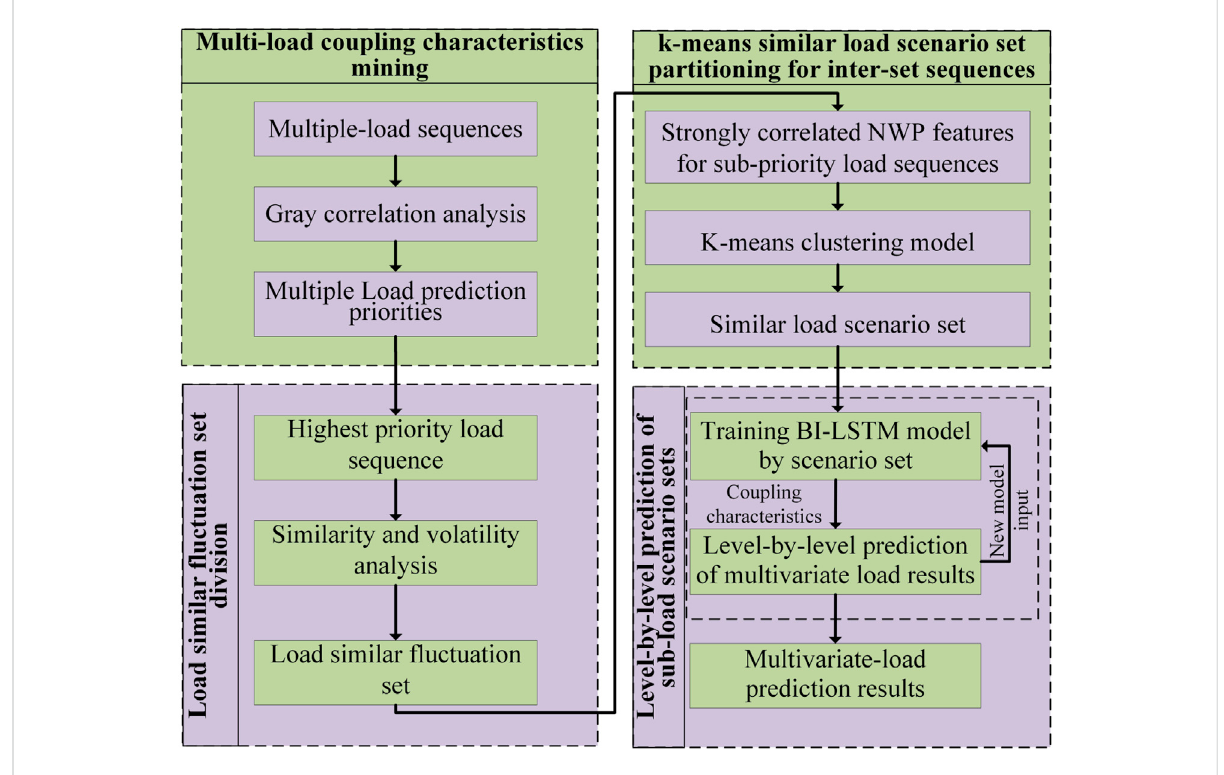
FIGURE 7 Flow chart of multivariate load data